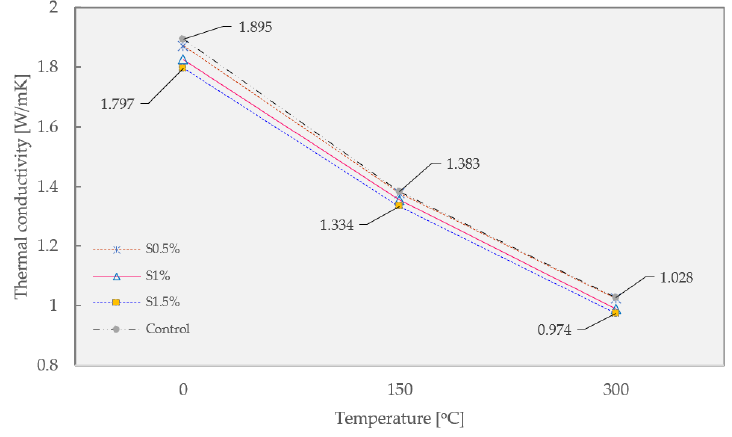
Figure 6. Thermal conductivity test results of guss mastic asphalt mixture modified by Sasobit.